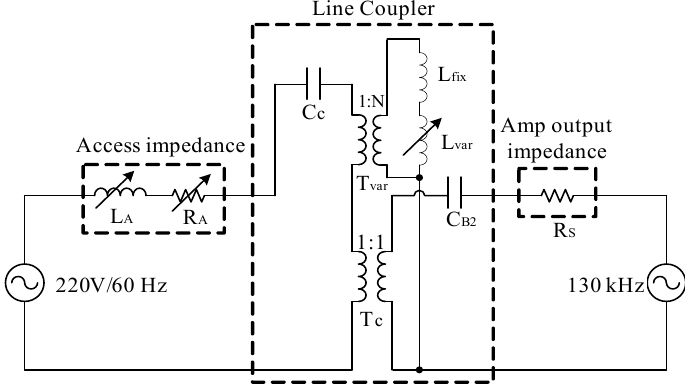
Figure 3. Adaptive impedance matching system using VCGIC [74].